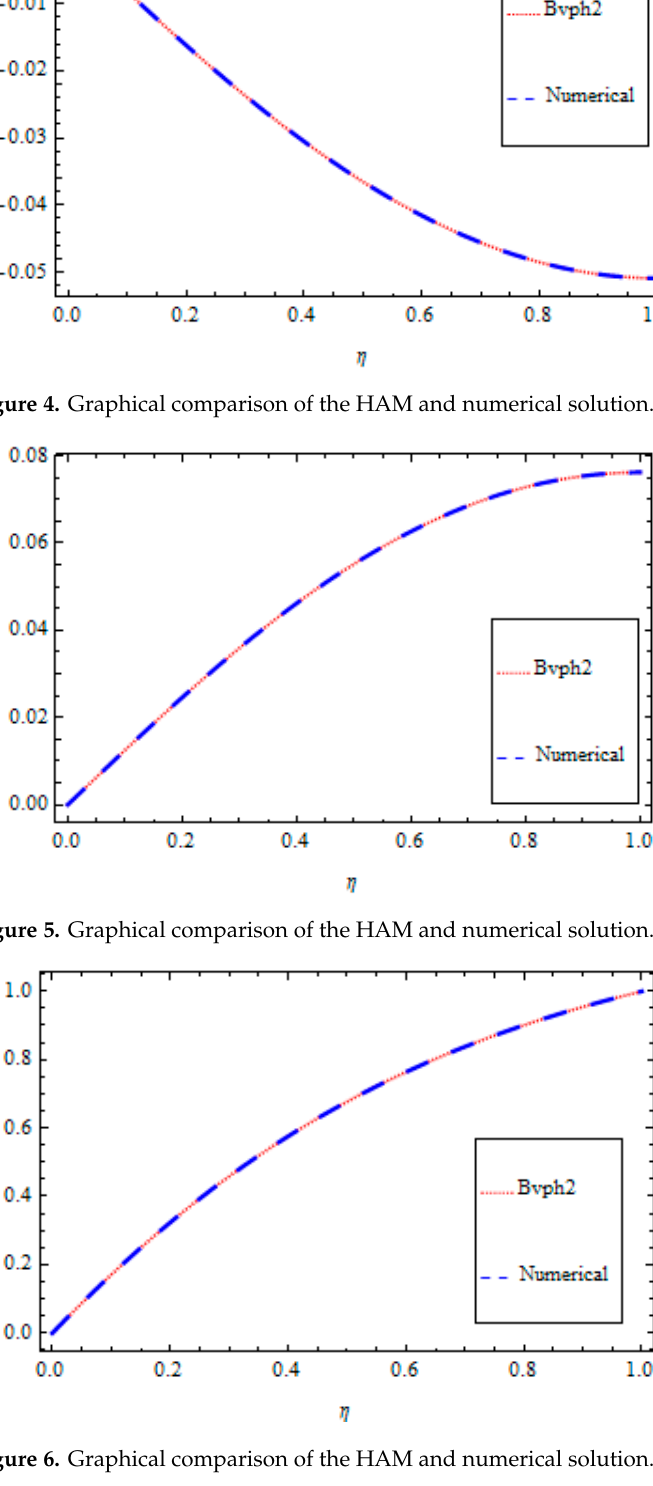
Figure 6. Graphical comparison of the HAM and numerical